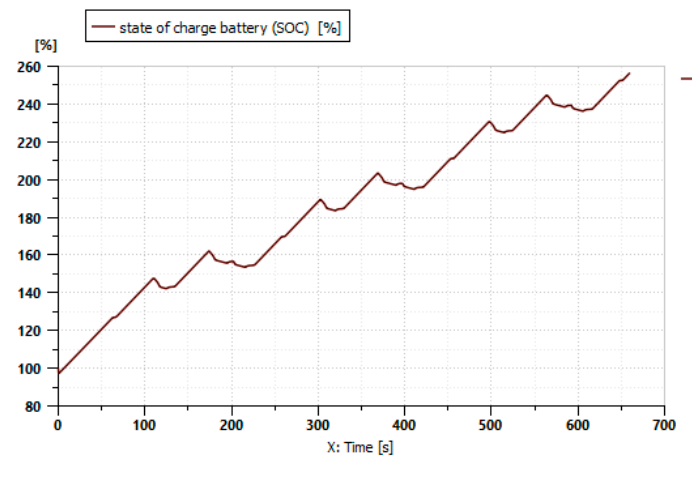
Figure 20. Battery’s state of charge.